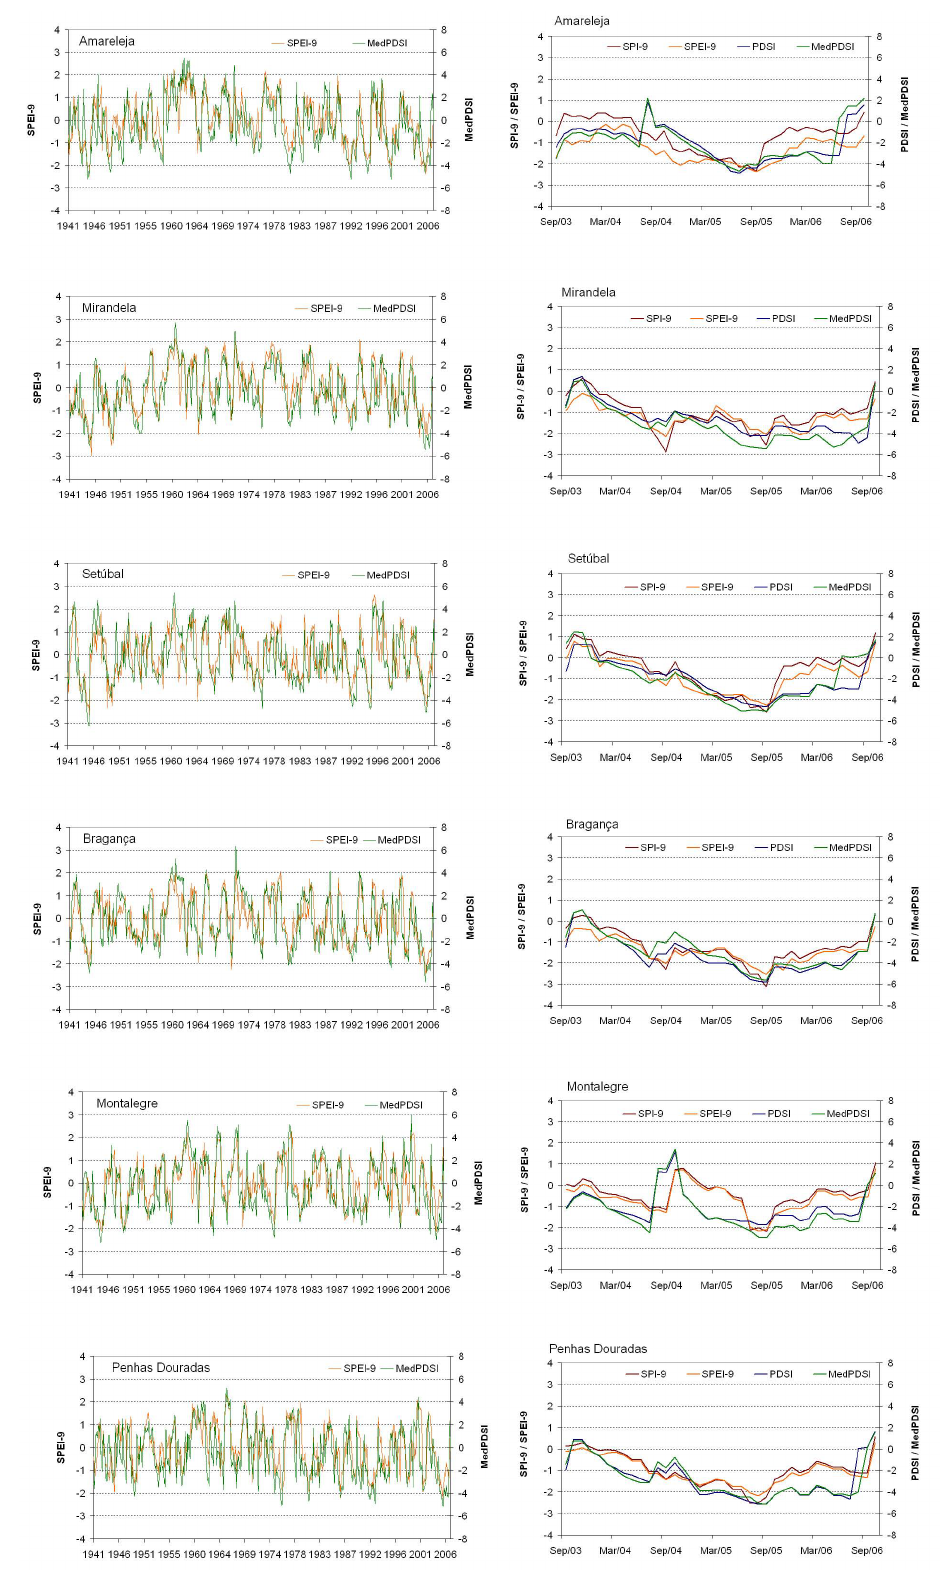
Fig. 5. Time series of SPEI-9 and MedPDSI (1941–2006) and of SPI, SPEI, PDSI, and MedPDSI in selected locations during the severe drought of